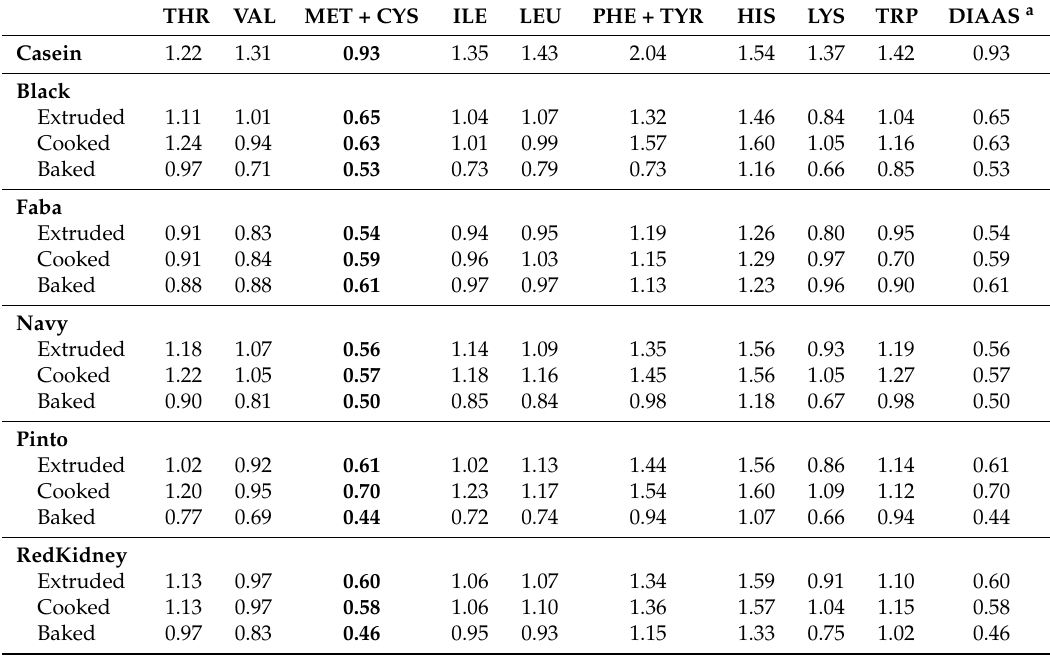
Table 5. Digestible indispensable amino acid scores of extruded, cooked and baked